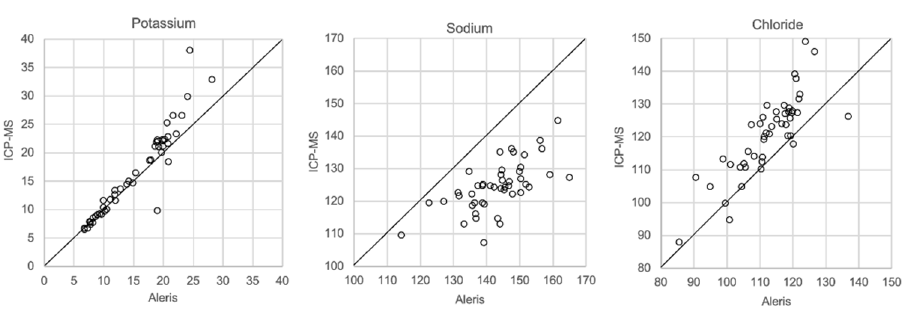
Figure 4. Comparison of Beckman Coulter AU5800 and ICP-MS. Table 2. Impact of cells and centrifugation. Means and standard deviations of the concentrations of potassium, sodium and